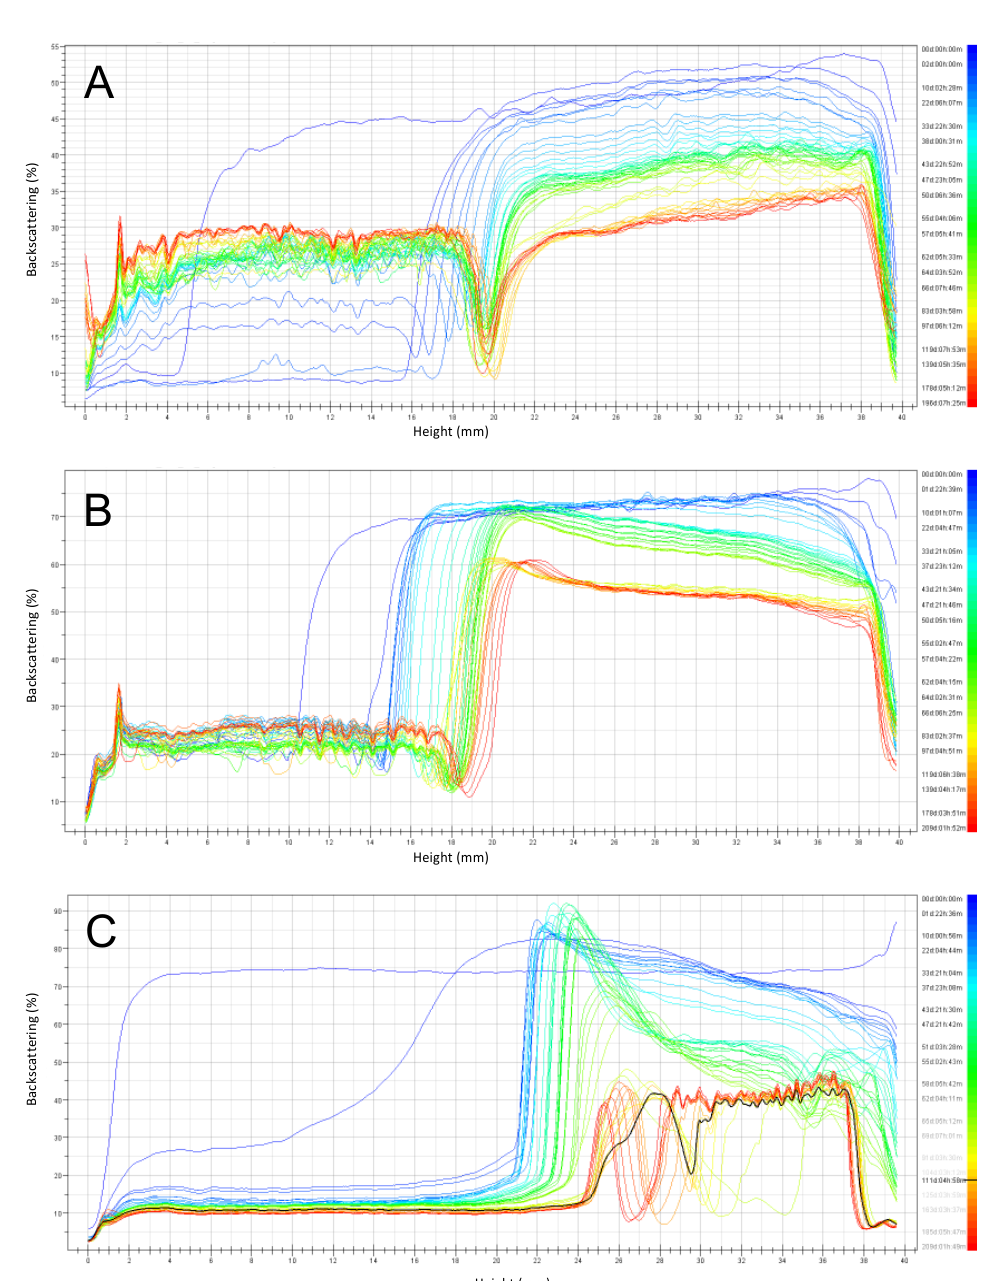
Figure 7. Emulsion backscattering profiles prepared at pH 3 and stored for six months at 4 °C. ( A ) Emulsions stabilized by rapeseed protein precipitated at pH 3 (RPP3), ( B ) Emulsions stabilized by rapeseed protein precipitated at pH 6.5 (RPP6.5), ( C ) Emulsions stabilized by soy lecithin.